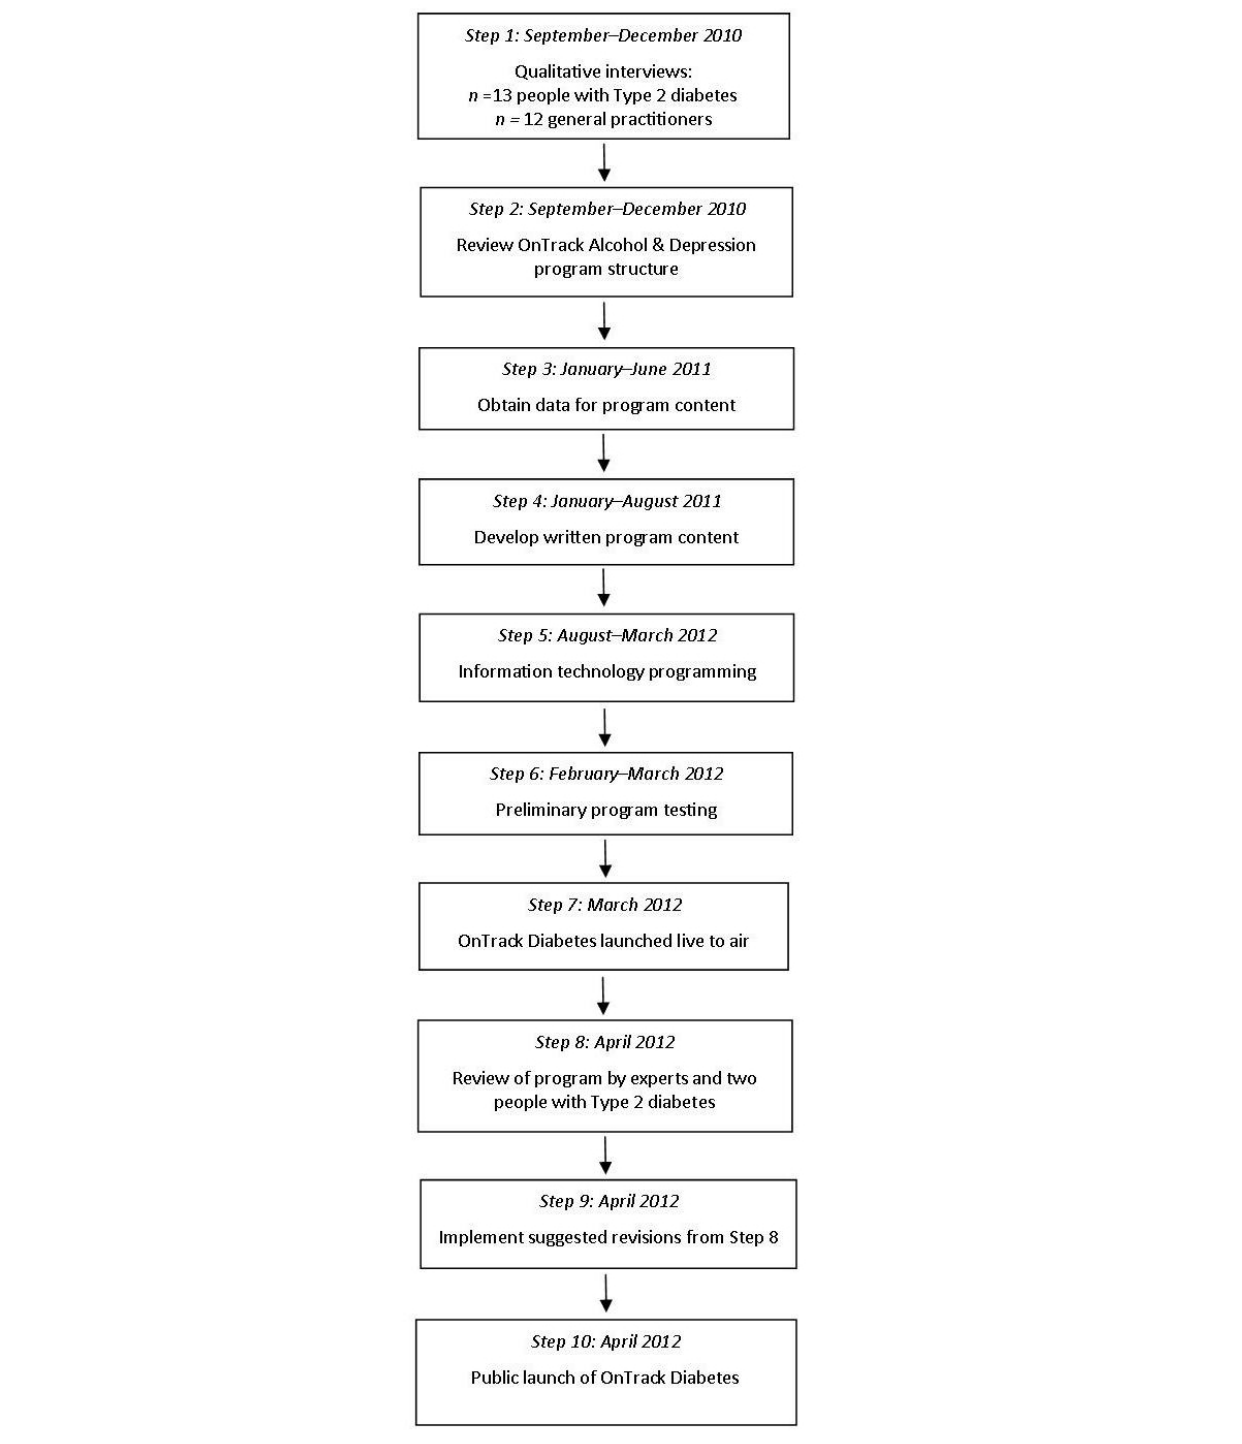
Figure 1. Steps involved in OnTrack Diabetes program